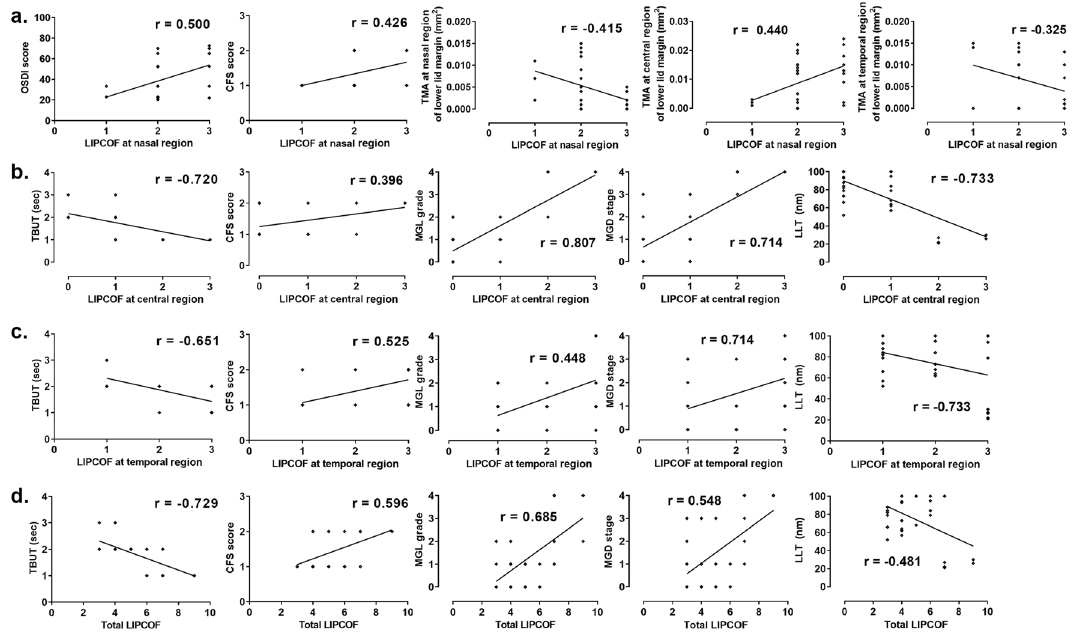
Figure 2. Correlation between the severity of conjunctivochalasis and ocular surface parameters. Among all ocular surface indexes, significant parameters related to each conjunctivochalasis (CCh) are shown with their coefficients ( r ) after the Spearman correlation analysis. (LIPCOF, lid-parallel conjunctival folds; OSDI, ocular surface disease index; CFS, corneoconjunctival fluorescein staining based on Oxford schema; TMA, tear film meniscus cross-sectional area measured by anterior segment optical computed tomography; TBUT, tear film break-up time; MGL, meibomian gland loss; MGD, meibomian gland dysfunction; LLT, lipid layer thickness).